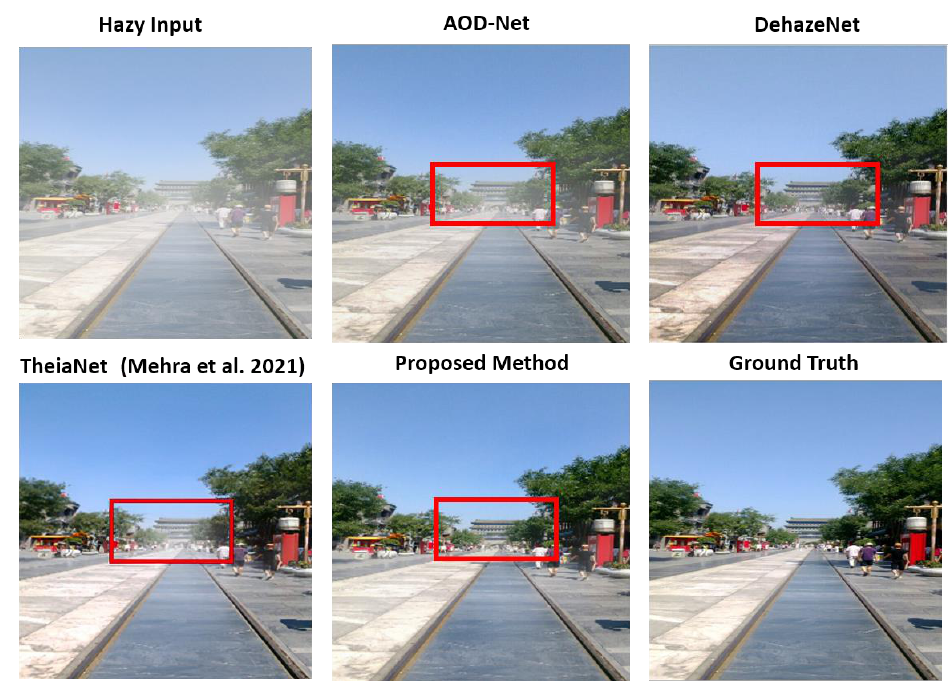
Figure 11. Comparison of dehazing results of distant haze [20].